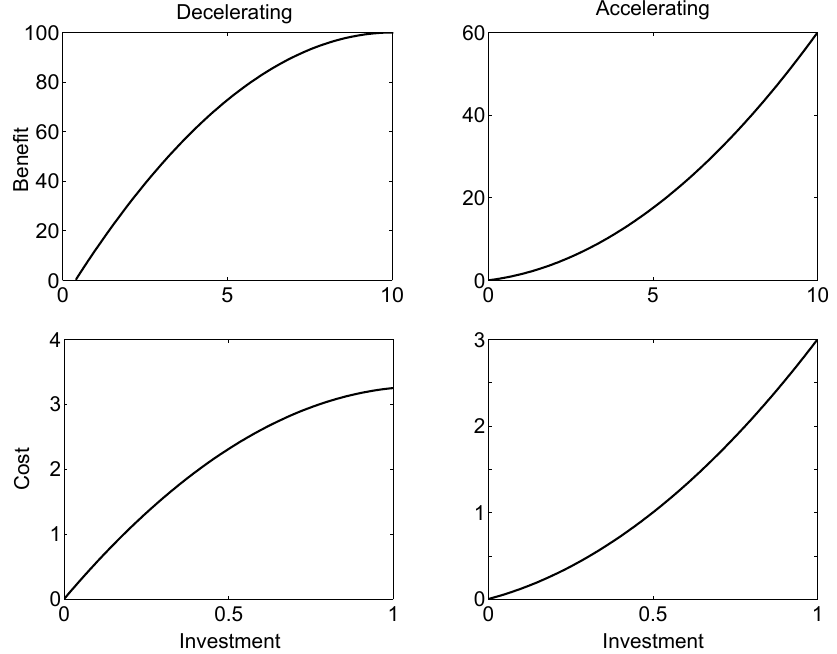
Figure 1. Examples of cost and benefit functions. Parameters used are for decelerating benefit b 2 = − 1, b 1 = 20; for accelerating benefit b 2 = 0.5, b 1 = 1; for decelerating cost c 2 = − 2.75, c 1 = 6; and for accelerating cost c 2 = 2, c 1 = 1. In choosing the horizontal range for the plots of the benefit functions, we have assumed N =